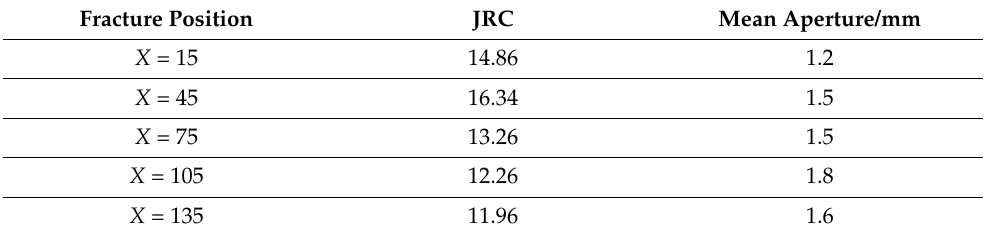
Table 2 lists the JRC and mean aperture of the fractures. Table 2. Fracture geometry